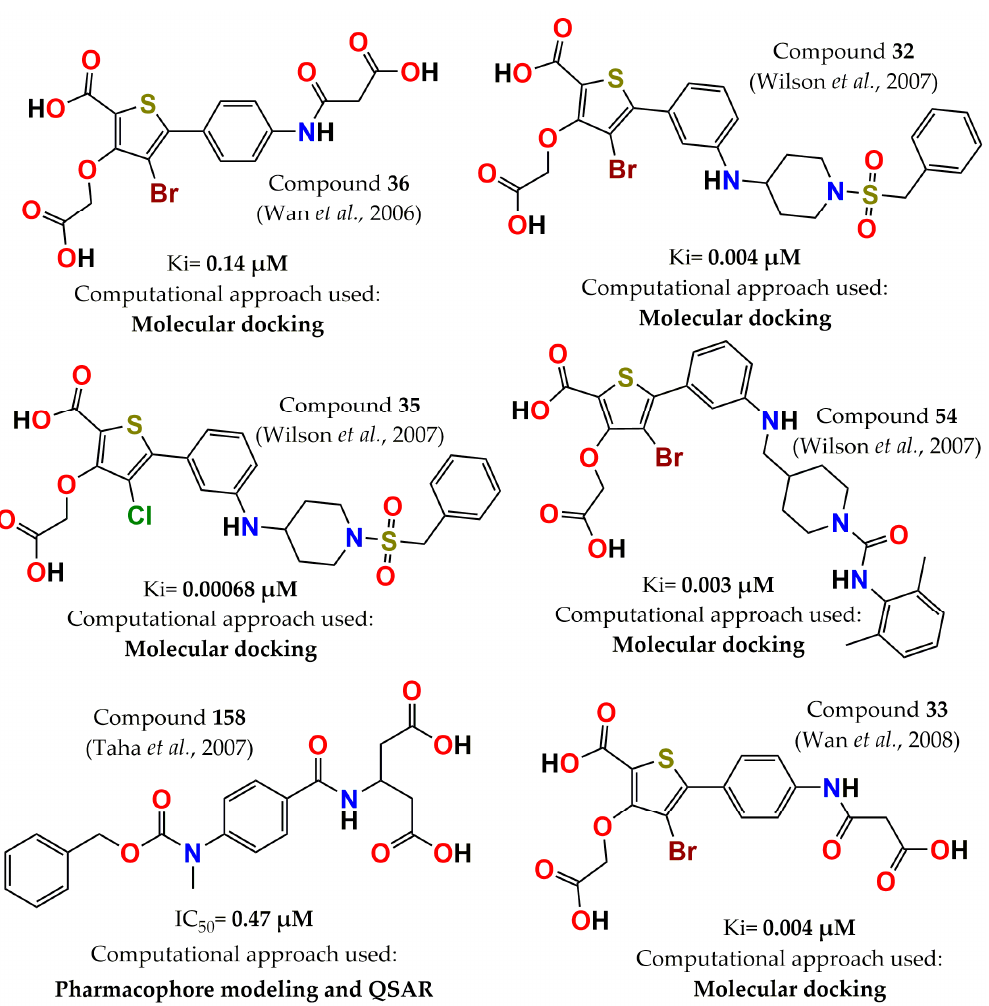
Figure 4. Structure of the most potent PTP1B inhibitors reported between 2006 and 2008 discovered through computational approaches.